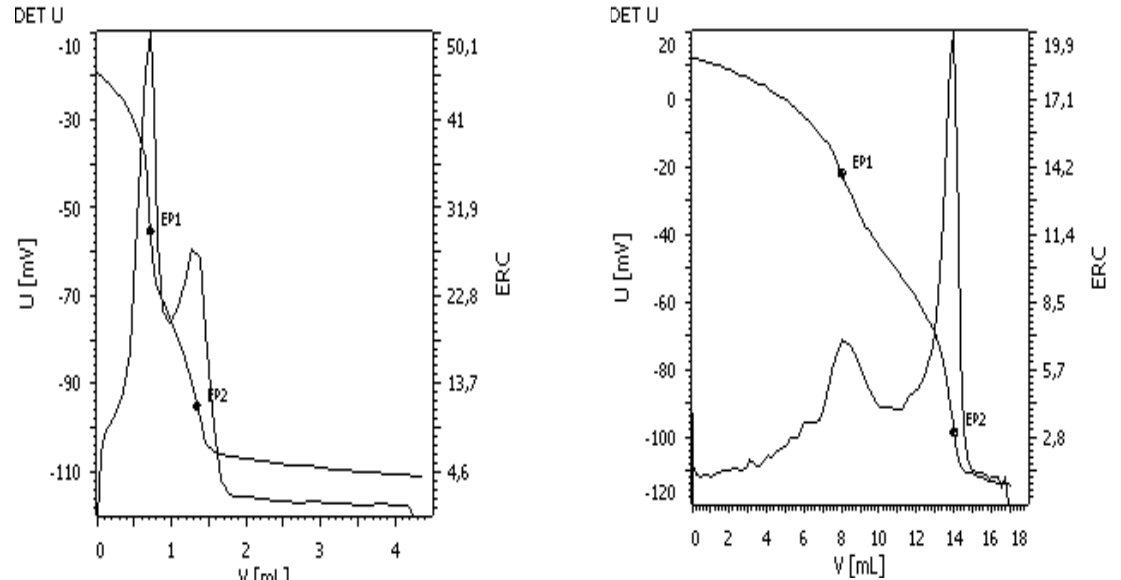
Figure 1. Curves obtained by ISE-CT and Ca 2+ (Ca 2+ + Mg 2+ ) in (a) blank samples and (b) soil